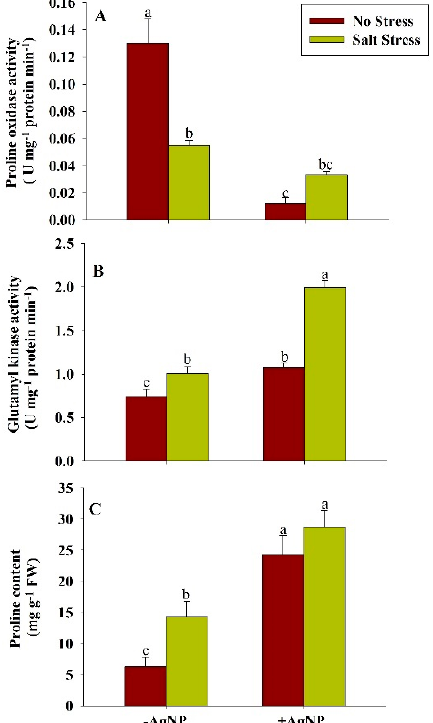
Figure 4. Estimation of proline metabolism: ( A ) proline oxidase activity ( B ) glutamyl kinase activity, and ( C ) proline content in wheat at 30 DAS. Plants were grown individually with 0 (control), 100 mM NaCl, 300 ppm AgNPs and NaCl combined with AgNPs. Data are presented as treatments mean ± SE (n = 3). Data followed by the same letter are not significantly different by LSD test at ( p ˂ 0.05).